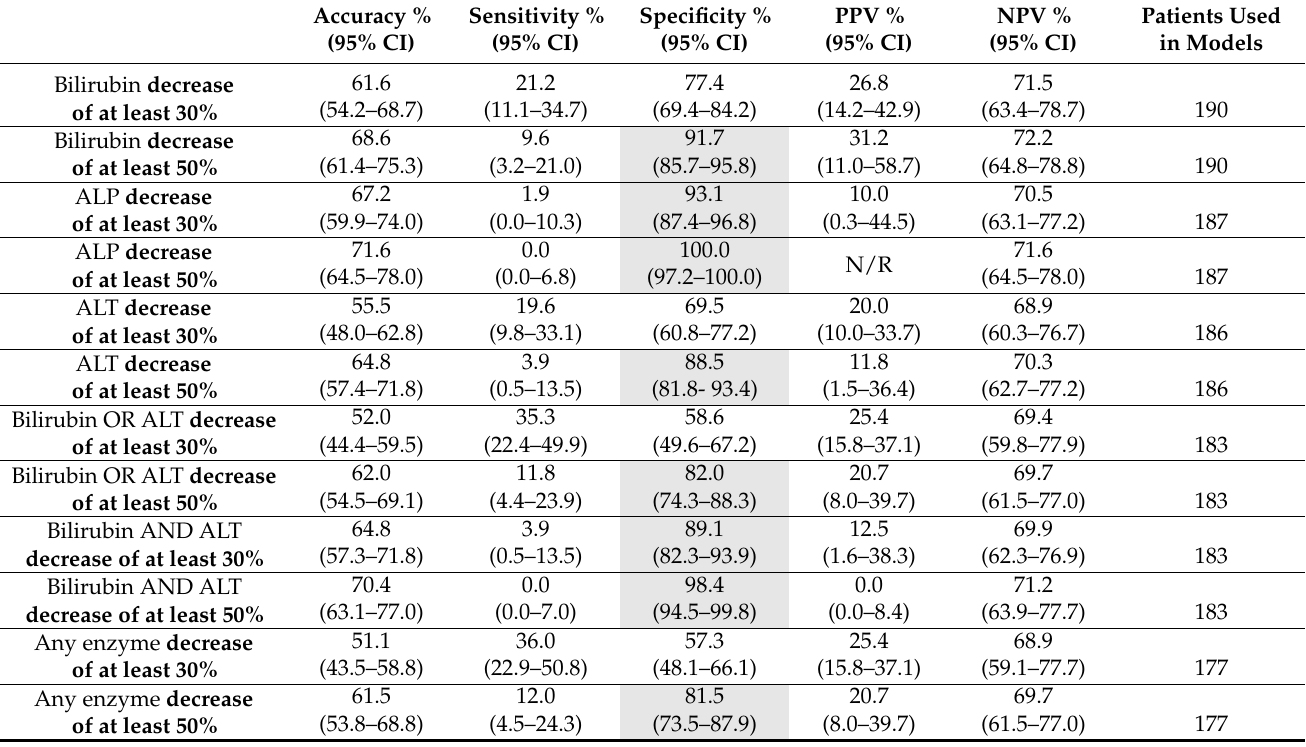
Table 4. Performance characteristics of a decrease in liver enzymes within 72 h preceding ERCP or EUS as a predictor of the absence of choledocholithiasis